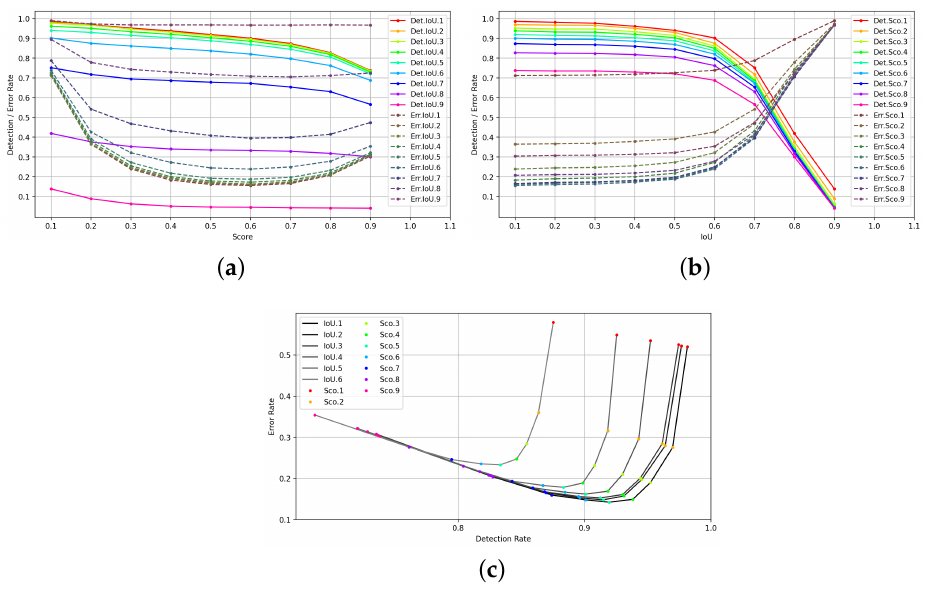
Figure 9. ( a ) is the curves of detection rate and false-alarm rate with confidence threshold for NMS threshold of 0.1. ( b ) is the curves of detection rate and false-alarm rate with IoU threshold for NMS threshold of 0.1. The corresponding curve colors for different confidence levels are shown in the legend on the right. ( c ) is an enlarged view of the lower-right area of Figure